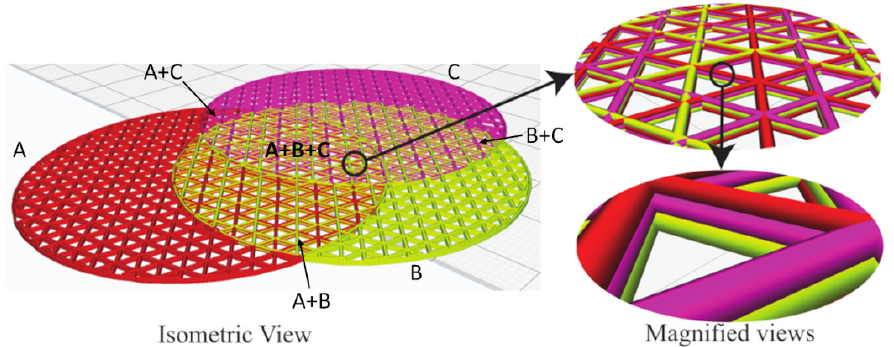
Figure 8. Visualization of interlaced infills on a model of three overlapping cylinders with materials A , B , and C .